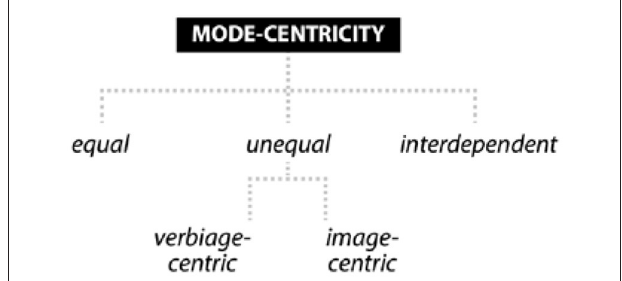
FIGURE 8 | Taxonomic overview of concepts for an analysis of mode-centricity in print ads.